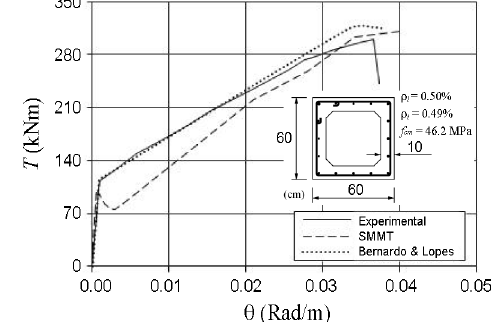
Fig. 4. T – θ curves for Beam D4